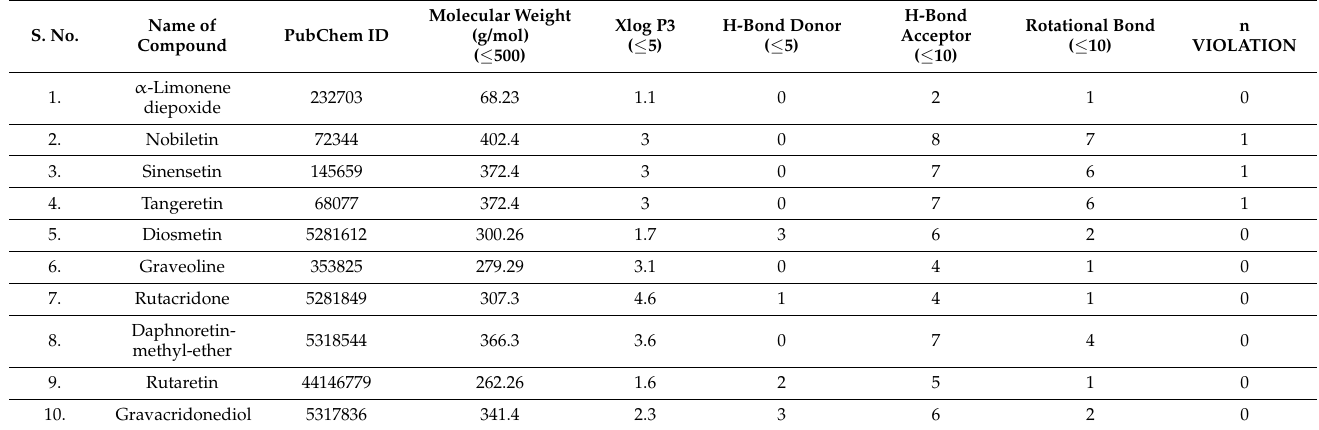
Table 1. Screened compounds following the drug-likeliness test.